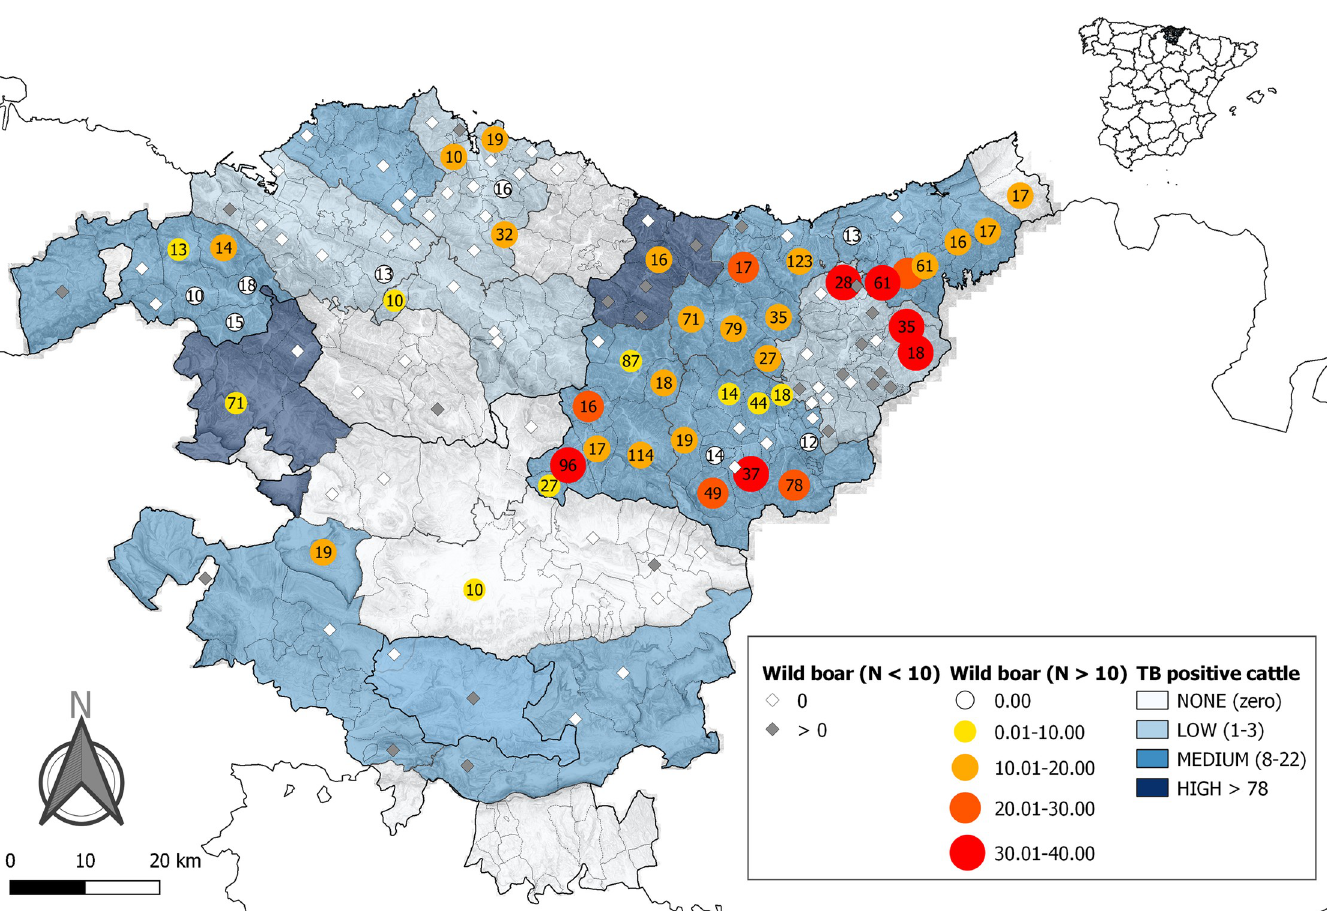
Fig 1. Spatial distribution of MTC seroprevalence (%) detected in wild boar and bovine TB positive cattle. Dot sizes and intensity of colour increase with the seroprevalence detected in municipalities where more than 10 wild boars were analysed. Labels inside these dots indicate the number (N) of animals analysed. Rhombuses indicate municipalities where less than 10 wild boars were analysed. Those in white mean they were negative and greys mean at least one animal was positive. Blue fill colour intensity increase with the number of TB positive cattle detected in each region: No (zero), low (1–3), medium (8–22) and high ( > 78).